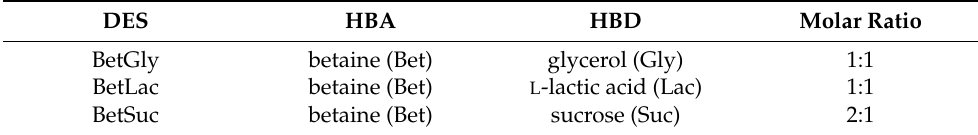
Table 3. DESs prepared for